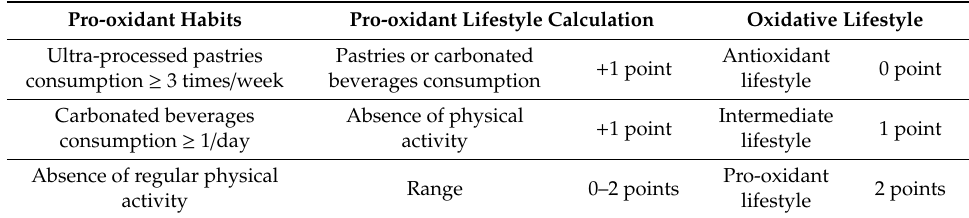
Table A1. Pro-oxidant lifestyle definitions.